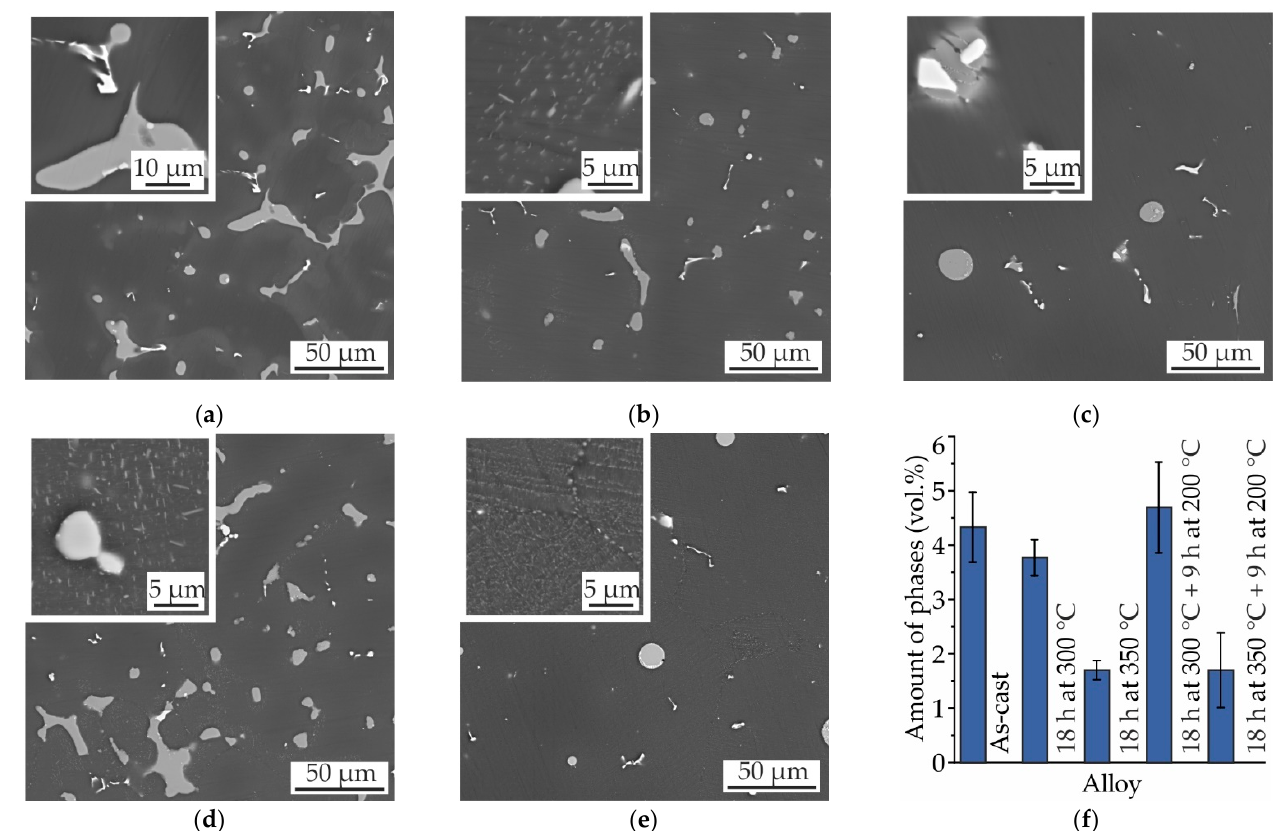
Figure 7. SEM micrographs of MgZn4Ga4Y0.5: ( a ) as-cast; after T4 heat treatment: ( b ) 18 h at 300 °C, ( c ) 18 h at 350 °C; and after T6 heat treatment: ( d ) 18 h at 300 °C and 9 h at 200 °C, ( e ) 18 h at 350 °C and 9 h at 200 °C; and ( f ) the amount of intermetallic phases (Mg 7 Zn 3 , Mg 5 Ga 2 and GaY) in these conditions.